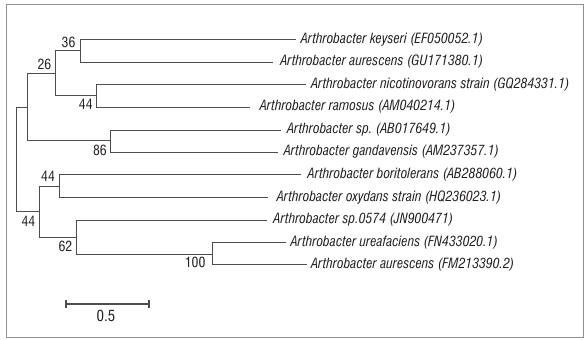
Figure 2: A neighbour-joining analysis tree of the strain Arthrobacter sp.0574 16S rDNA.